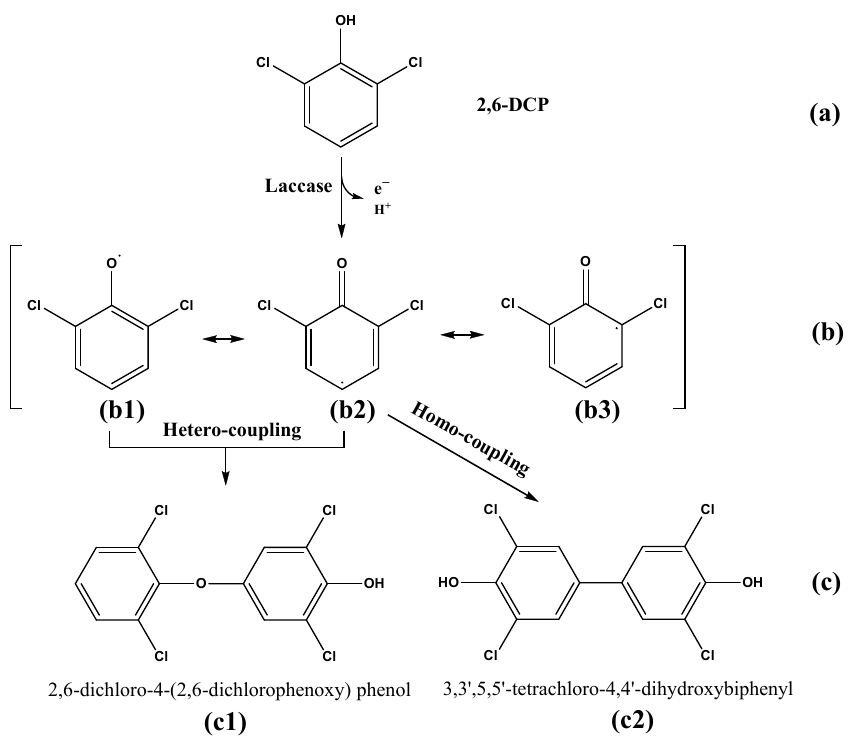
Figure 12. Speculation of the degradation pathway of 2,6-DCP catalyzed by LAC-4 laccase. The putative degradation pathway of 2,6-DCP catalyzed by LAC-4 laccase. ( a ) 2,6-DCP; ( b ) free radicals; ( c ) dimer products.